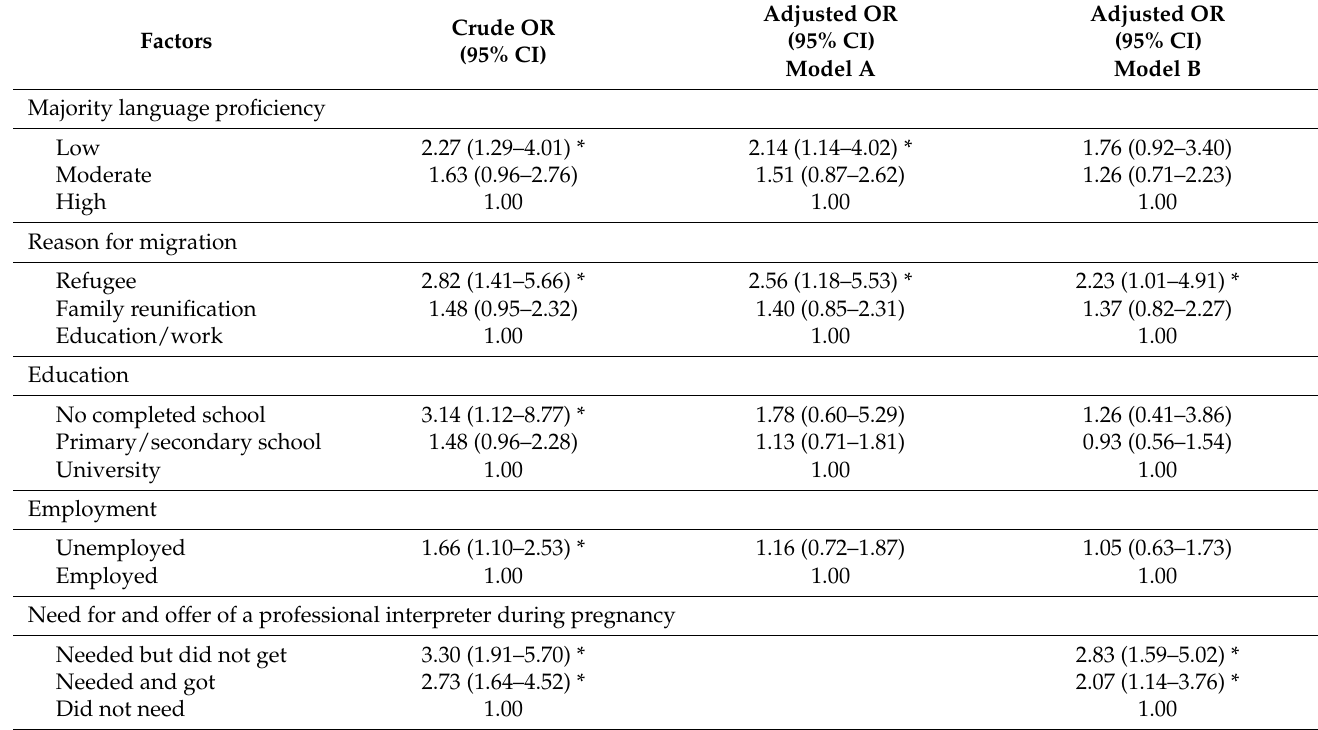
Table 2. Factors associated with poor understanding of information given by healthcare personnel during pregnancy, birth, and after